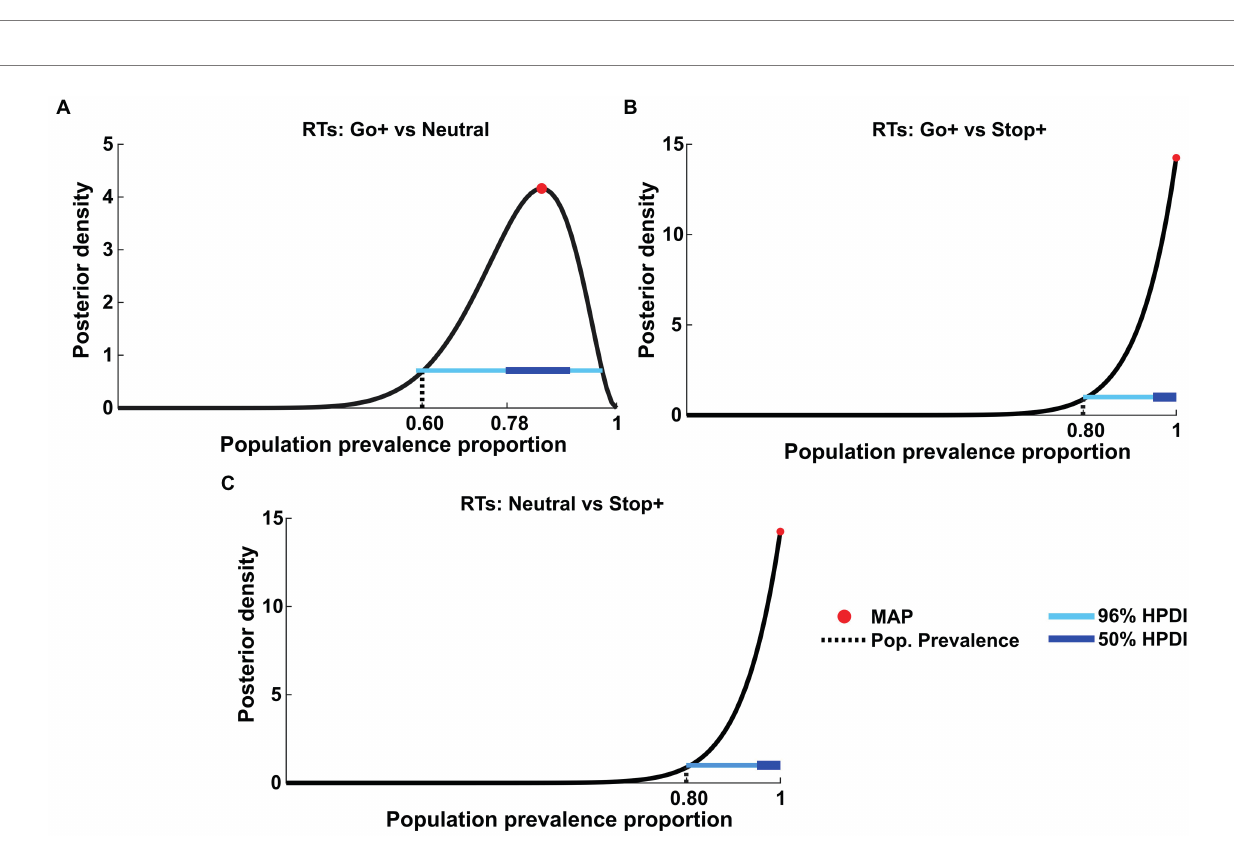
FIGURE 6 Bayesian inference of population prevalence for RTs. Each panel shows posterior density (black curve) with MAP (red circle), 50% and 96% HPDI (thick/ thin blue lines), obtained from within-subject inference at p = 0.05 of RTs for each Cue Condition interaction: (A) RTs tested on Go+ Condition versus Neutral Condition; (B) RTs tested on Go+ condition versus Stop+ Condition; (C) RTs tested on Stop+ Condition versus Neutral